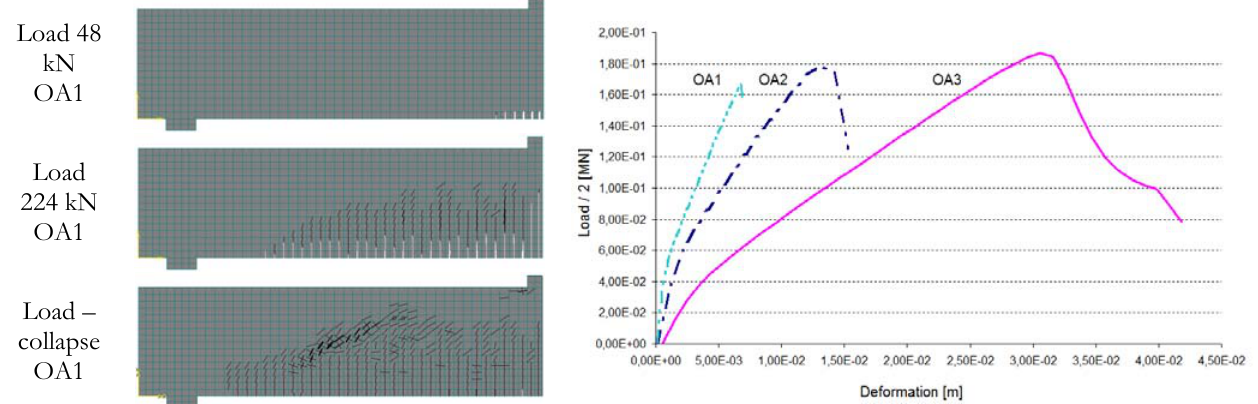
Figure 4: Failure in a beam, OA1. Figure 5: Load – displacement diagram for beams OA